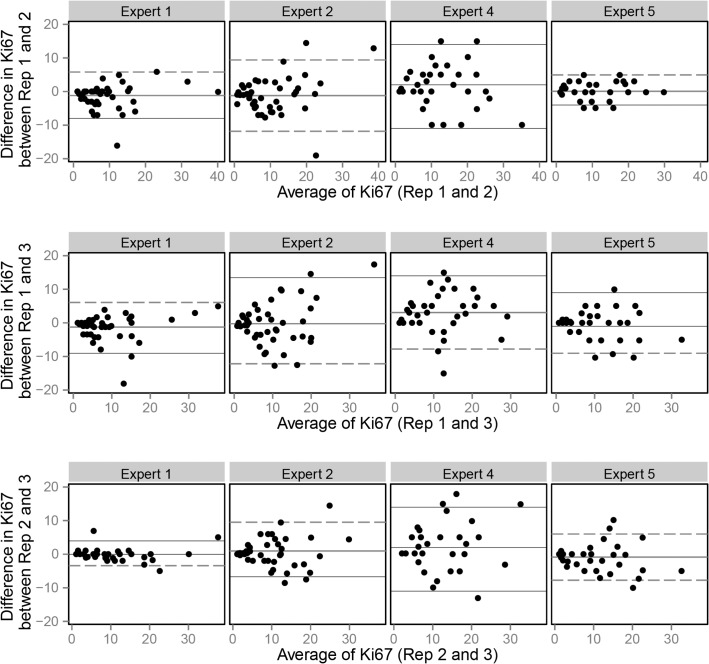
Bland Altmann plots for method C.